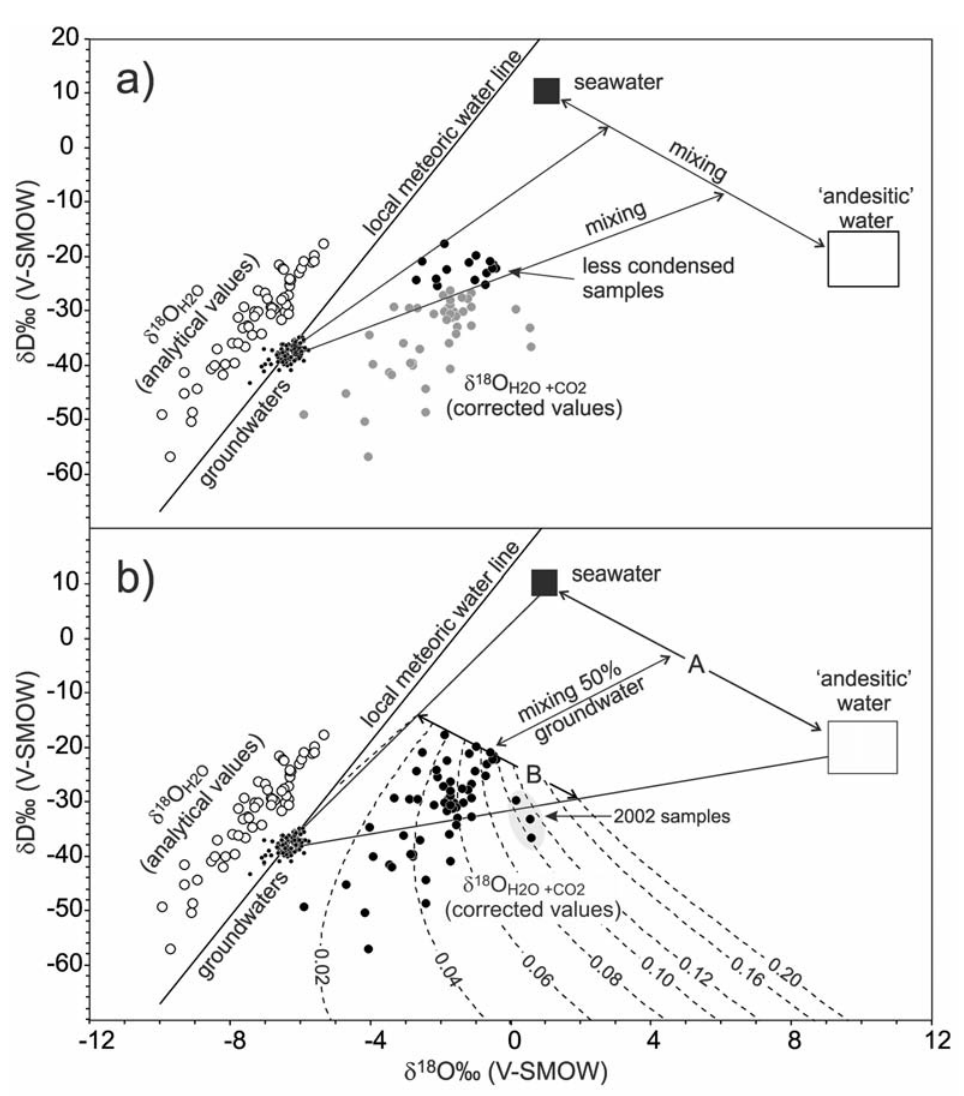
Figure 10. a) d D versus d 18 O diagram. Analytical isotopic compositions of fumarolic condensates and the computed d 18 O values of the H O+CO tot 2 2 system under discharged conditions are reported, together with the local meteoric water line [Caliro et al. 1998], isotopic composition of the groundwaters circulating in the volcanic aquifers of Vesuvius [Caliro et al. 2005] and other possible end-members of mixing (seawater and andesitic waters). The fumarolic data were more or less unaffect by condensation processes (i.e. more positive isotopic values, black dots) and they support an origin of the water due to a mixture of andesitic water, seawater and local meteoric water. b) Mixing-condensation model involving seawater, andesitic water and local =0; andesitic water d D=−20‰, d 18 O=10‰, groundwater. The assumed compositions of the end members are: seawater d D=10‰, d 18 O=1‰, X CO2 X =0.4; groundwaters: d D=−38‰, d 18 O=−6.3‰, X =0. The mixing line A represents the vapor generated by seawater–andesitic water mixtures. CO2 CO2 The mixing line B represents a dilution of line A by 50% in groundwater. Dashed lines represent the condensation patterns of line B vapors. The number molar fractions of the pre-condensed line B of dashed lines refer to the different CO 2